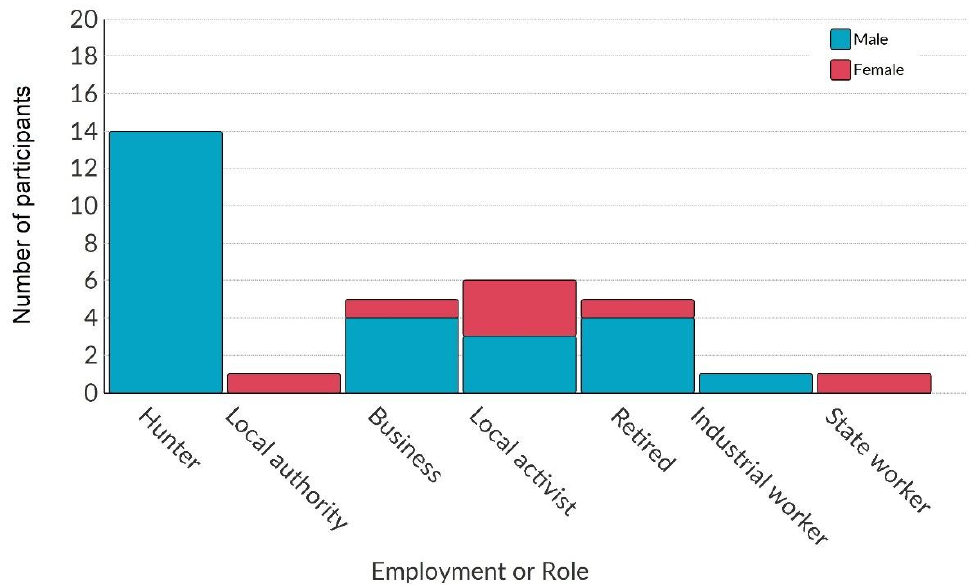
Figure 2. Demographics of interviewees discussing the topic of